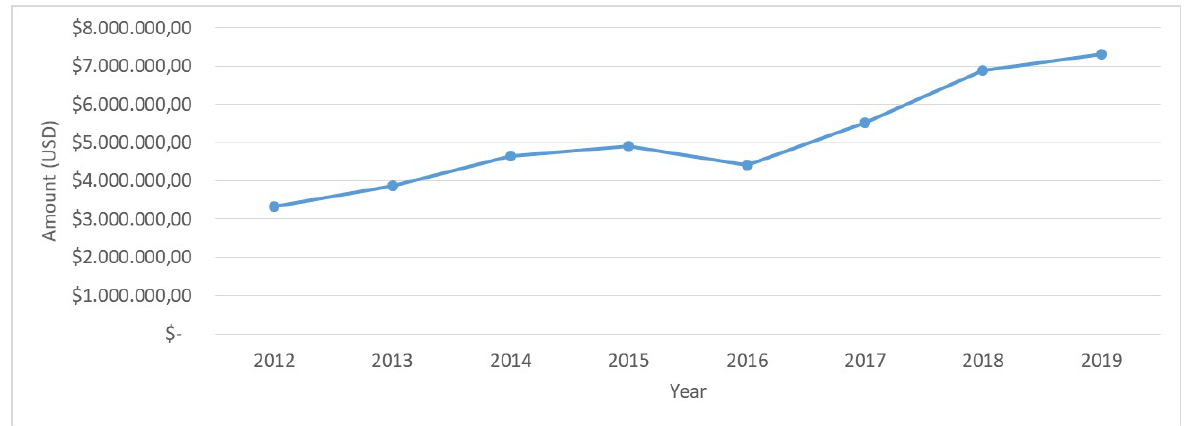
Figure 1. Evolution of the amounts spent on APCs in the 2012-2019 period. (Source: the authors).